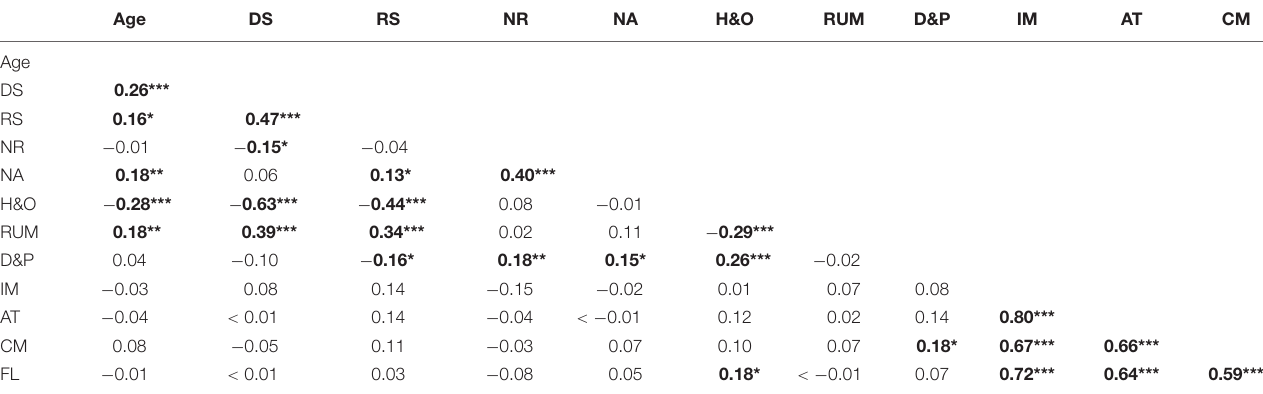
TABLE 3 | Correlations between age, depressive symptoms, and action mechanisms at pre-test and game engagement variables.